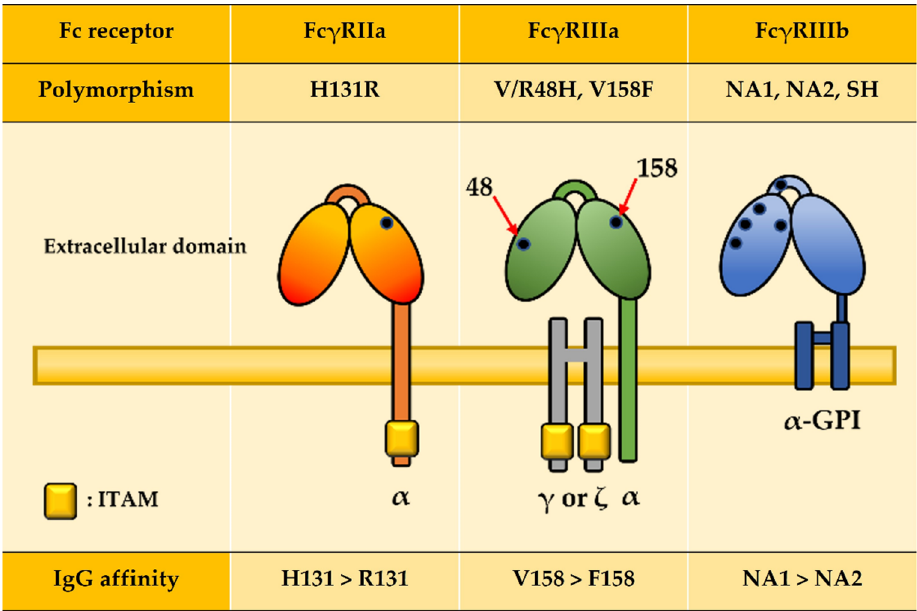
Figure 3. Polymorphisms affect immunoglobulin affinity. Black dots indicate amino acid residues that affect IgG affinity. H131 of Fc γ RIIa, V158 of Fc γ RIIIa, and NA1 of Fc γ RIIIb havehigher IgG affinity than the other alleles.